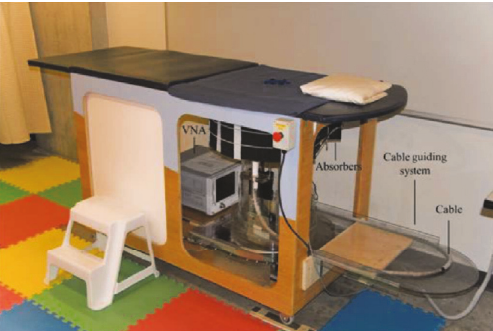
Figure 24: TSAR prototype system in Calgary University [28]. Image from Bourqui et al. 2012, under the Creative Commons Attribution License.